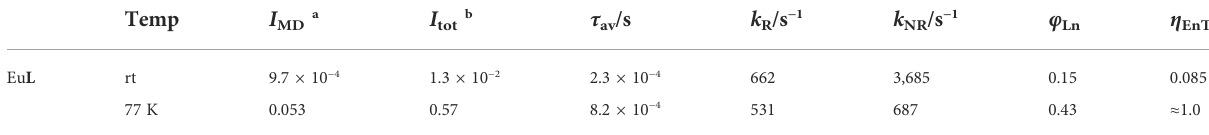
TABLE 3 Photophysical parameters of EuL in the solid state. ( a : λ ex = 380 nm, λ mon = 583 – 603 nm, b : λ ex = 380 nm, and λ mon = 550 – 750 nm). Temp